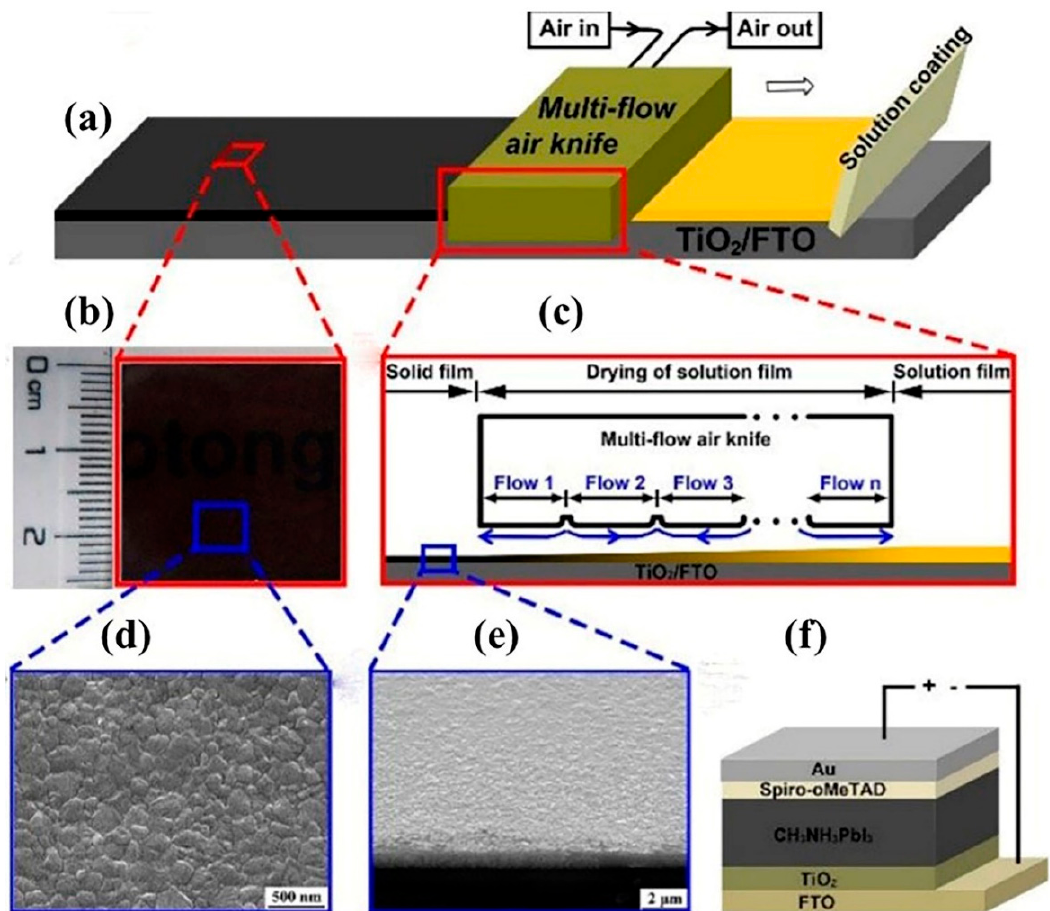
Figure 17. ( a ) Schematic diagram of the perovskite solution film drying process using the MAK method. ( b ) Photograph of a single piece of perovskite film prepared by means of the MAK method. ( c ) Cross-sectional schematic diagram of the MAK setup. ( d ) SEM surface image of perovskite film prepared using the MAK method. ( e ) Cross-sectional SEM image. ( f ) Structure diagram of planar perovskite solar cell [150]. Copyright 2017 Royal Society of Chemistry.